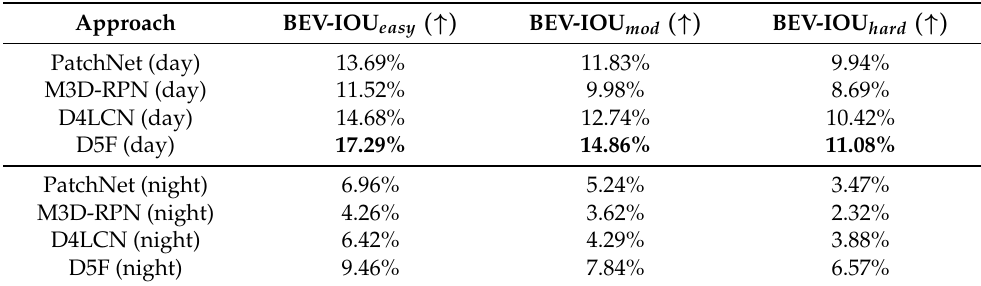
Table 7. Average precision in terms of BEV-IOU for three difficulty levels (BEV-IOU easy , BEV-IOU mod , and BEV-IOU hard ). The best values are displayed in